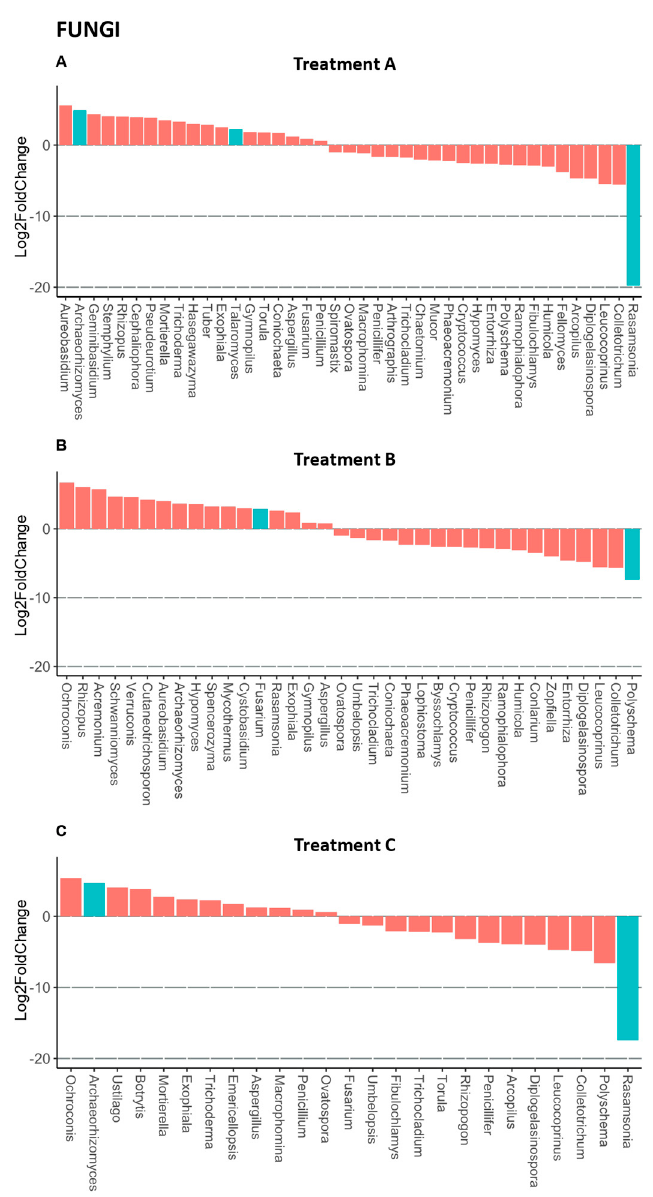
Figure 5. Changes in the relative abundance of the fungi genera as a function of treatments A ( A ), B ( B ), and C ( C ). The Y -axis represents the log2FoldChange. Only genera with p -values < 0.6 are depicted. For treatment B ( B.amyloliquefaciens ), two genera of fungi differed with respect to the control: Polyschema , given that it was more abundant in the control than in the treated plants, and Fusarium , given that it was more abundant in the treated plants than in the control (Figure 5B). For bacteria there were 18 associated genera for all of the treatments. In the treated samples, the taxa Conexibacter , Tumebacillus , Pullulanibacillus , Mycobacterium , FCPS473 , Nocardia , Paenibacillus , Alicyclobacillus , and Acidothermus were at higher pro- portions; while Koribacter , Hyphomicrobium , Pedomicrobium , Sphingomonas , Gemmatimonas , Solirubrobacter , and Actinomadura were more abundant in the control samples (Figure 6B). Treatment C (nutrient solution) produced changes in 2 fungal and 21 bacterial